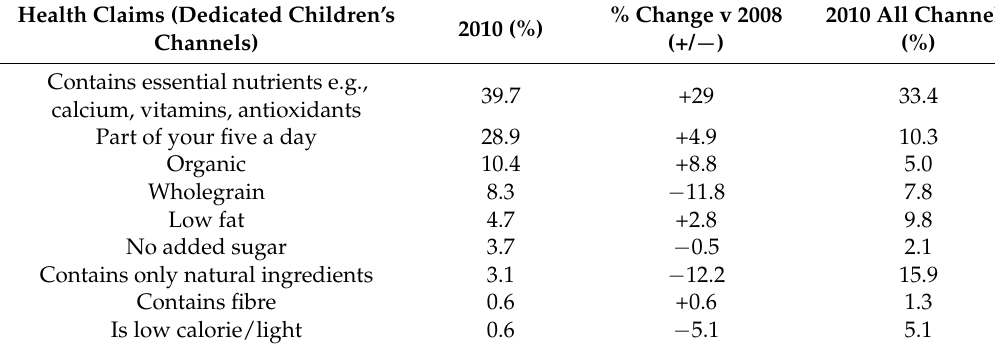
Table 2. The most heavily used health claims on dedicated children's channels in 2010, change from 2008 health claim use across all channels in